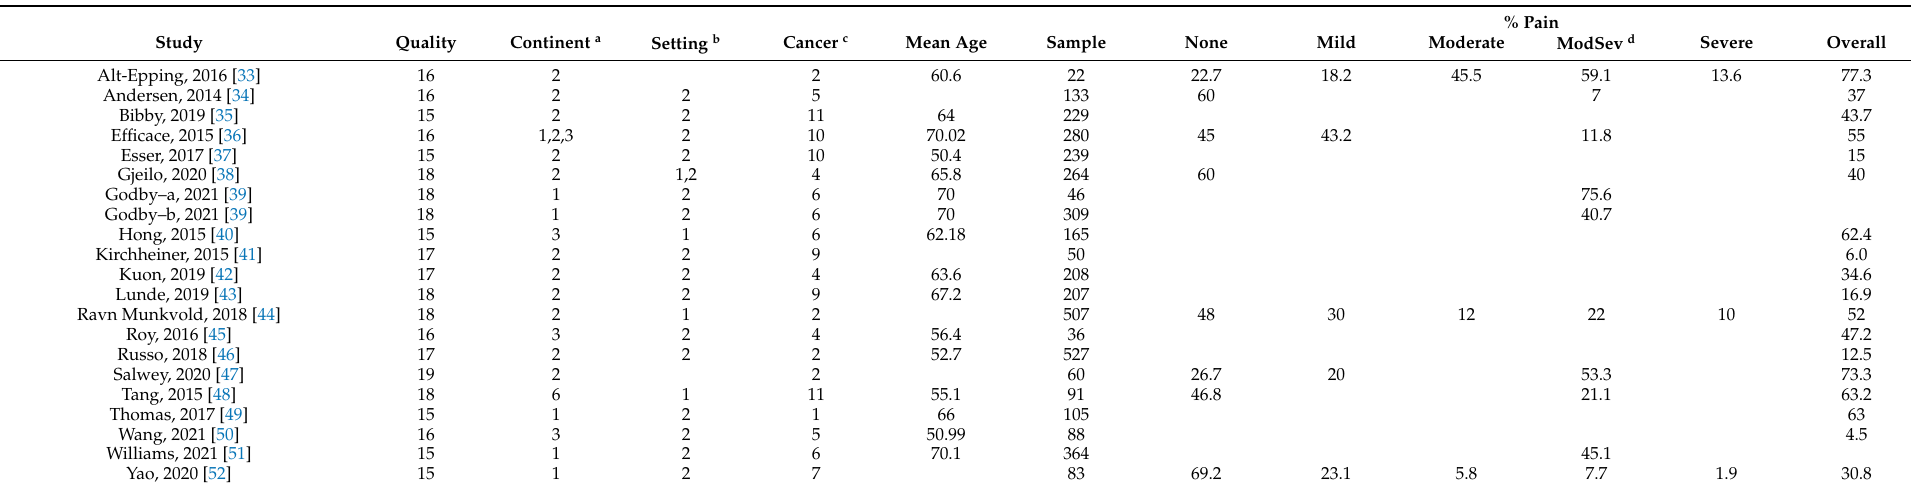
Table 2. Pain prevalence in treatment-naïve cancer patients (Group 1) ( n = 20).